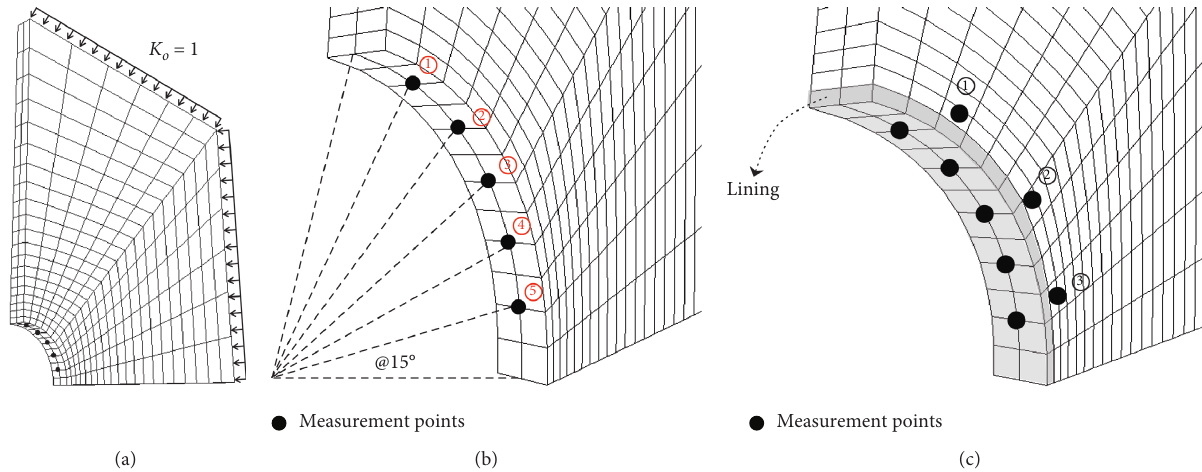
Figure 4: Construction of a numerical model and monitoring of displacement and stress. (a) Quarter-symmetry numerical model. (b) Displacement monitoring along the excavated tunnel periphery. (c) Stress and displacement monitoring along the lined tunnel periphery. Table 1: Material properties used in the numerical study. Lining